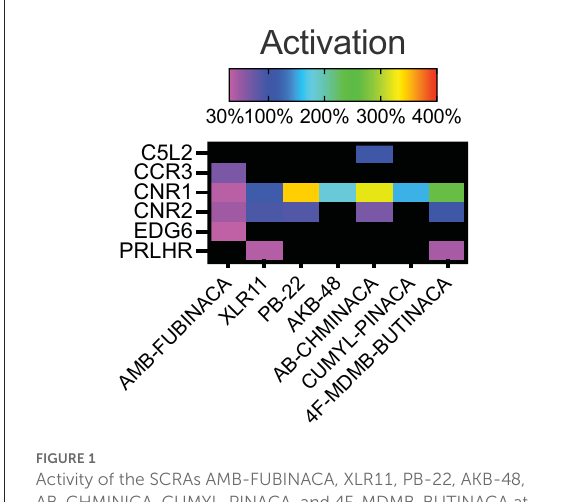
FIGURE1 Activity of the SCRAs AMB-FUBINACA, XLR11, PB-22, AKB-48, AB-CHMINICA, CUMYL-PINACA, and 4F-MDMB-BUTINACA at 30 µ M in a β -arrestin recruitment screen. Heatmap depicting targets where above-threshold activation ( > 30%) was reached with at least one SCRA. The full list of targets screened is included as Supplementary Table